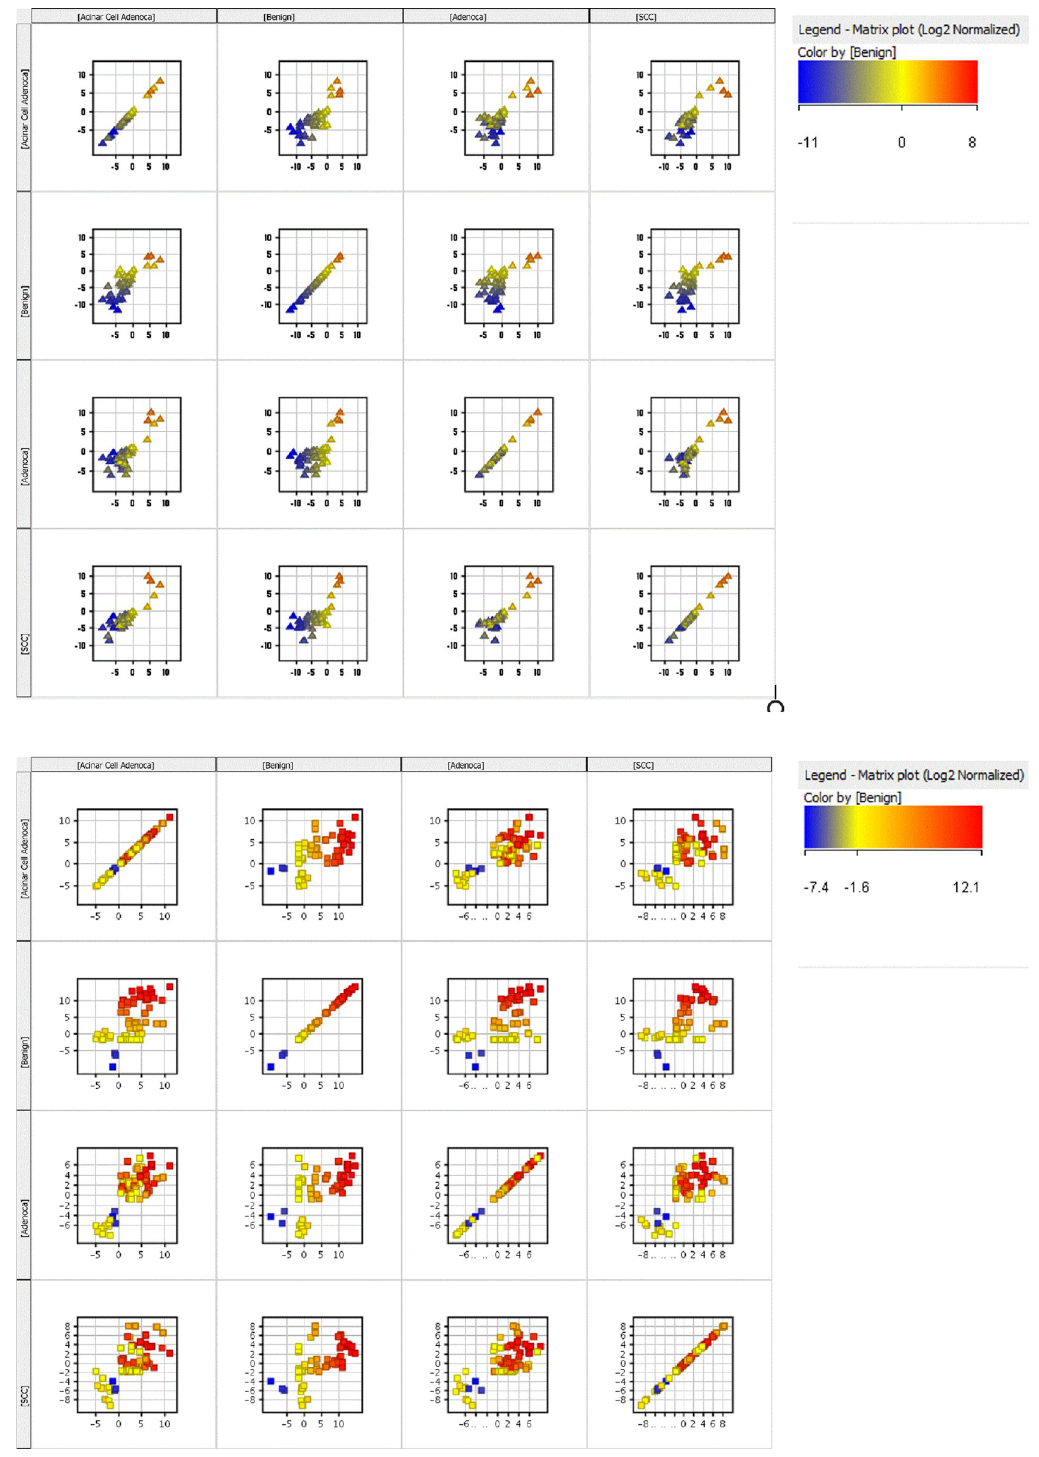
Fig 5. a. Matrix plot of pairwise 2D scatter plots for patients with benign and the three selected cancers (Esi Pos). b. Matrix plot of pairwise 2D scatter plots for patients with benign and the three selected cancers (Esi Neg).